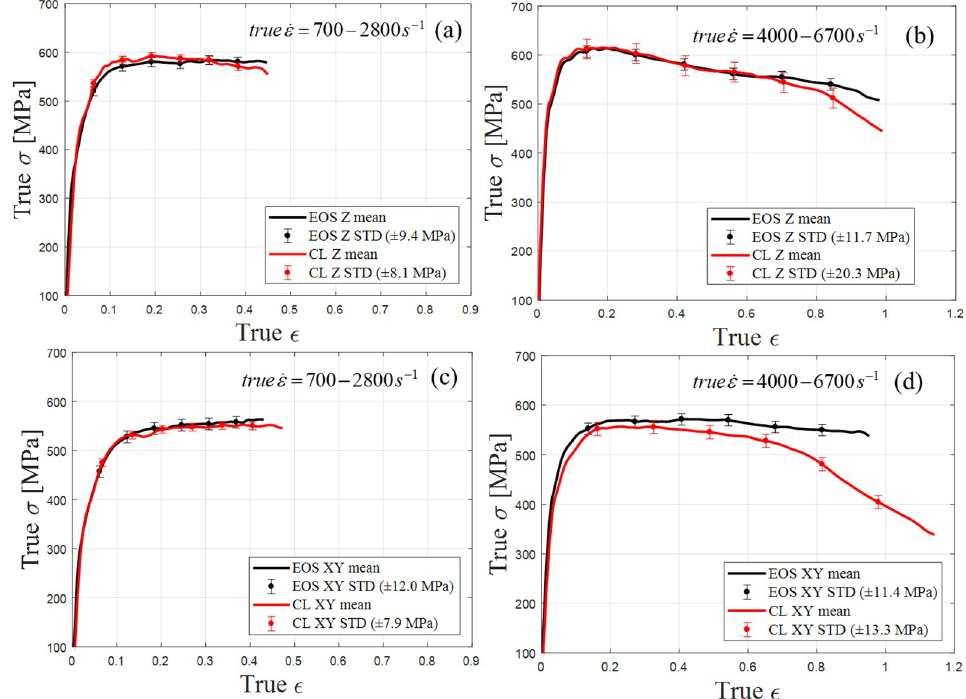
Figure 11. CL vs. EOS samples mean value and standard deviation (STD) of true stress–true strain curves: ( a ) Comparison between Z-oriented samples at true strain rate range of 700 to 2800 s − 1 ; ( b ) comparison between Z-oriented samples at true strain rate range of 4000 to 6700 s − 1 ; ( c ) comparison between Z-oriented samples at true strain rate range of 700 to 2800 s − 1 ; and ( d ) comparison between XY-oriented samples at true strain rate range of 4000 to 6700 s − 1 .